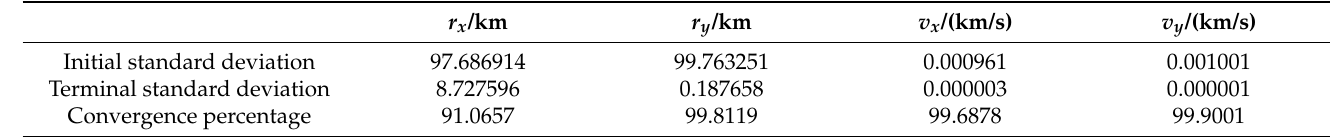
Table 3. Analysis of the 3-sigma curve of the 2th orbital